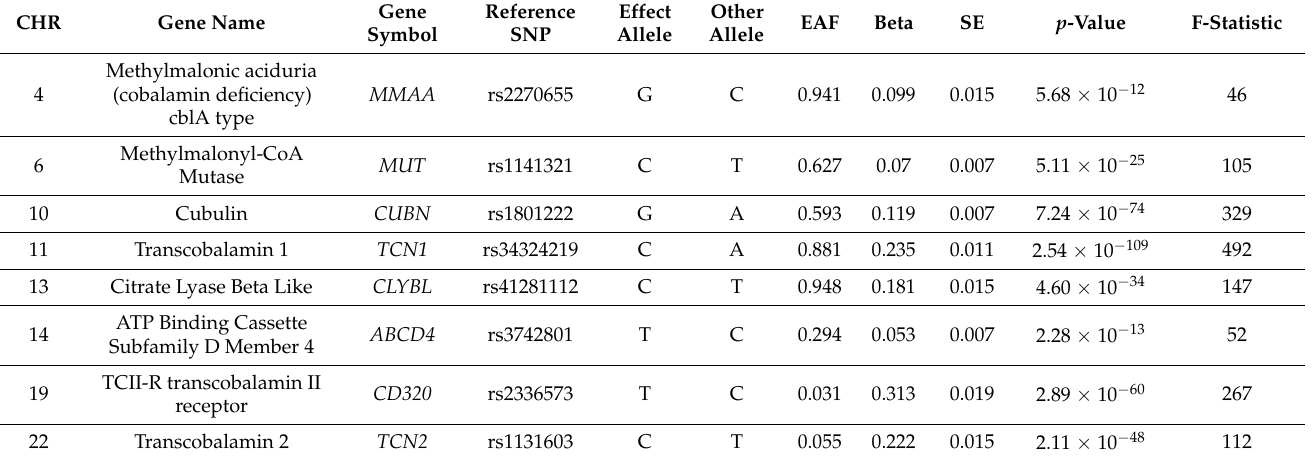
Table 1. Genetic instruments used for the computation of a vitamin B 12 genetic risk